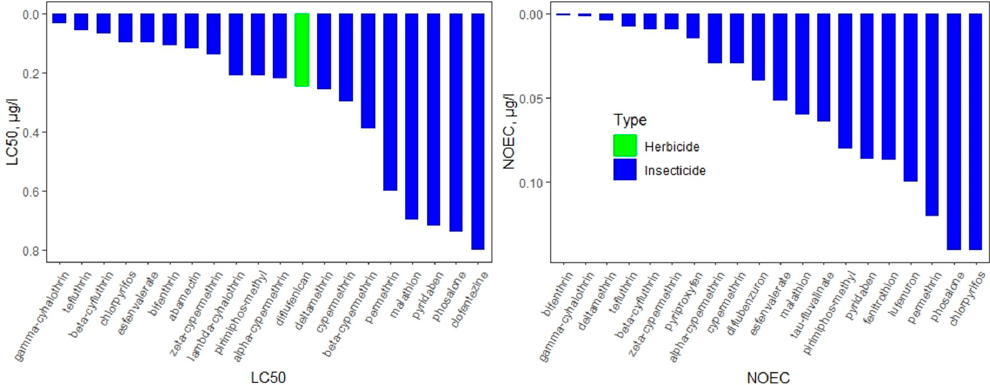
Figure 10. Ratings of the pesticide toxicity for the most sensitive group of aquatic organisms.